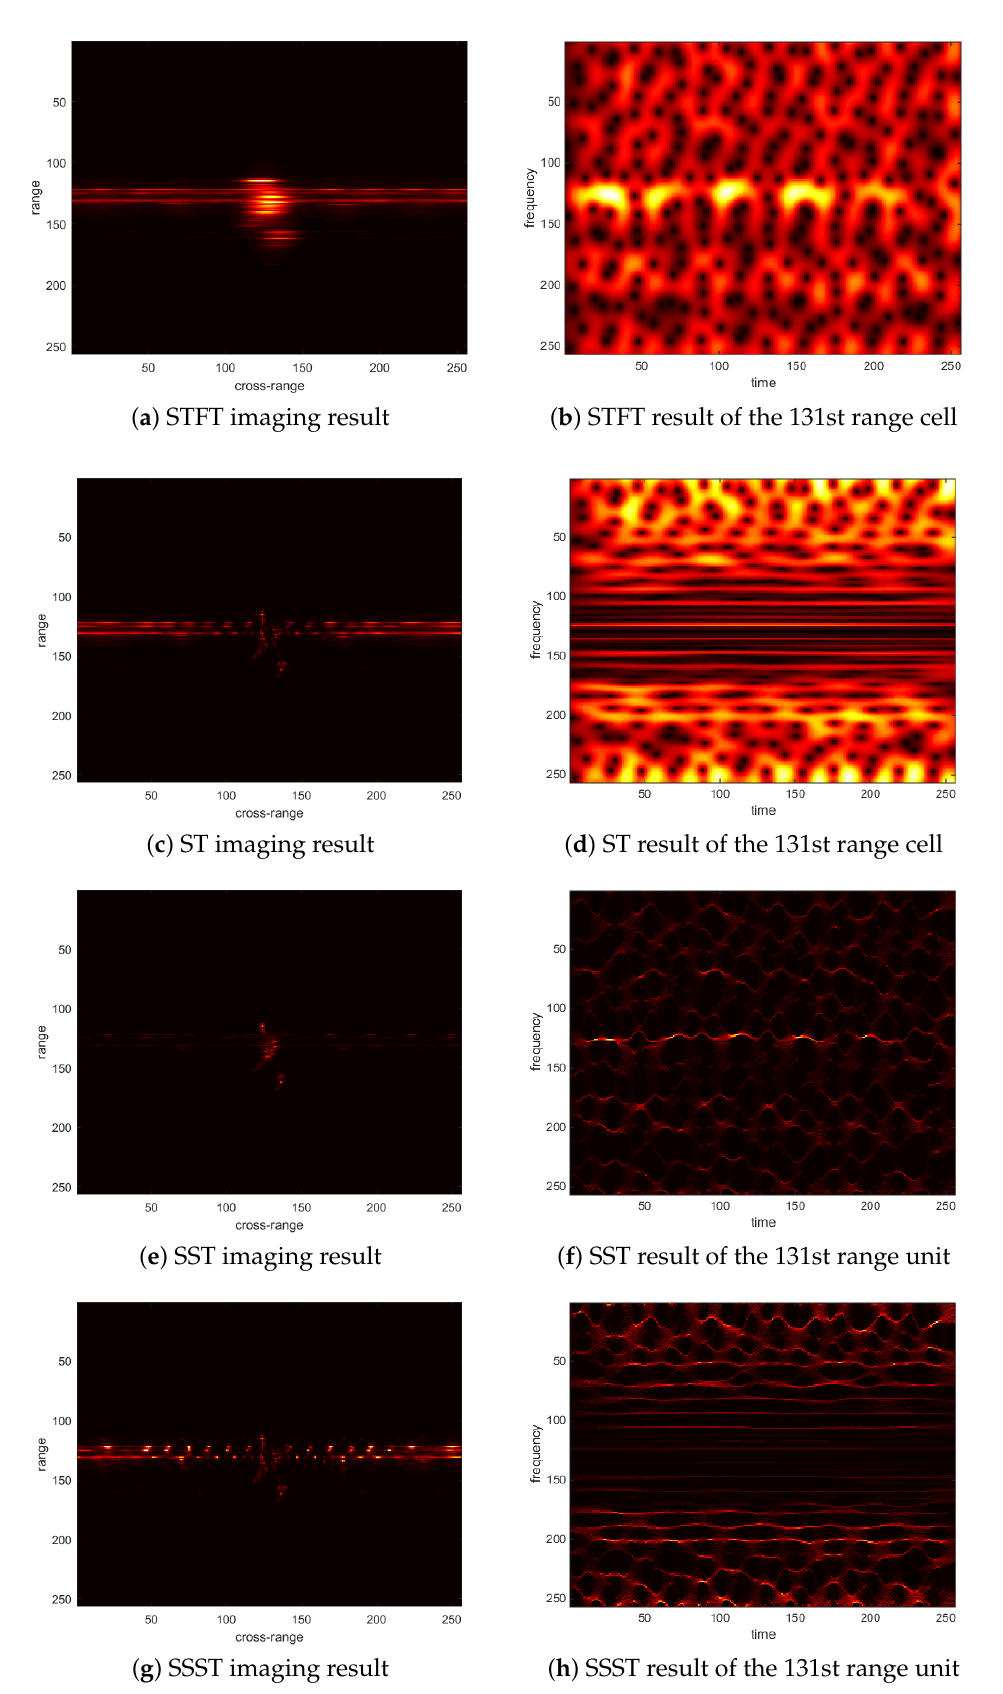
Figure 9. Time-frequency and imaging analysis results of real An-26